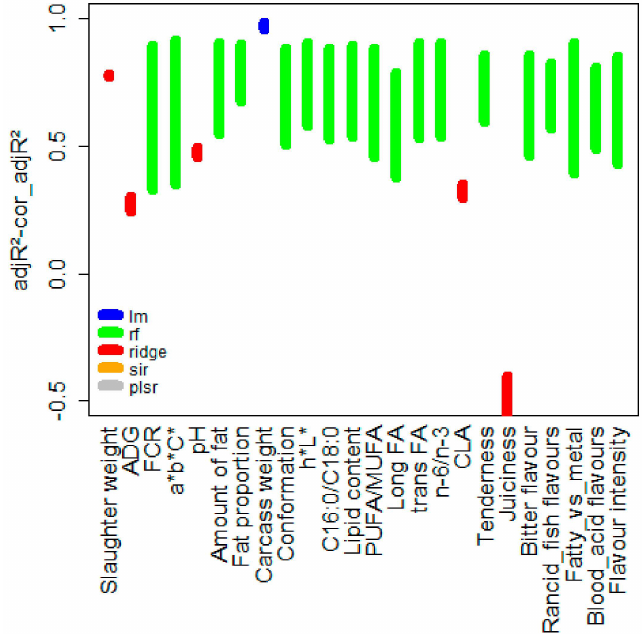
Figure 1. Quality of the 24 prediction models based on the adjusted coe ffi cient of determination calculated twice, represented by vertical segments. The upper (respectively lower) limit of the interval corresponds to the adjusted R 2 (calculated on the training data) (respectively corrected adjusted R 2 estimate with a bootstrap approach [23]). The color indicates the model selected from the five competing regression models (lm = linear model, rf = random forest, ridge, sir = slice inverse regression, plsr = partial least square